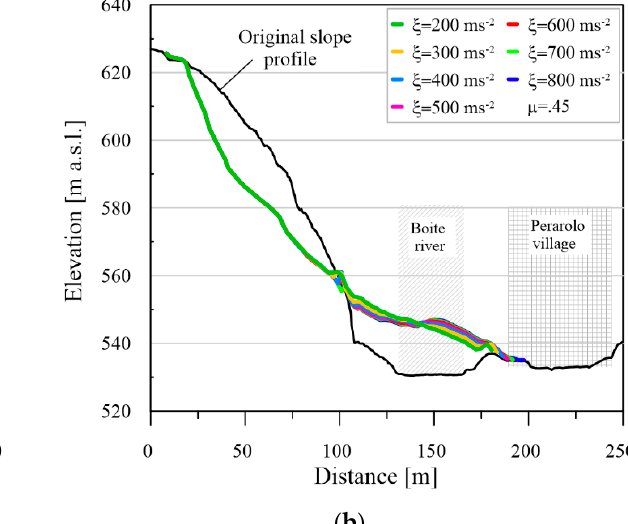
Table 5. Rheological and numerical parameters adopted in the propagation simulation in wet and dry conditions.